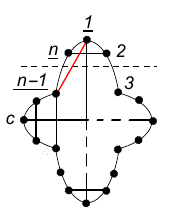
Figure 18 . Factorization contribution of a non-ladder